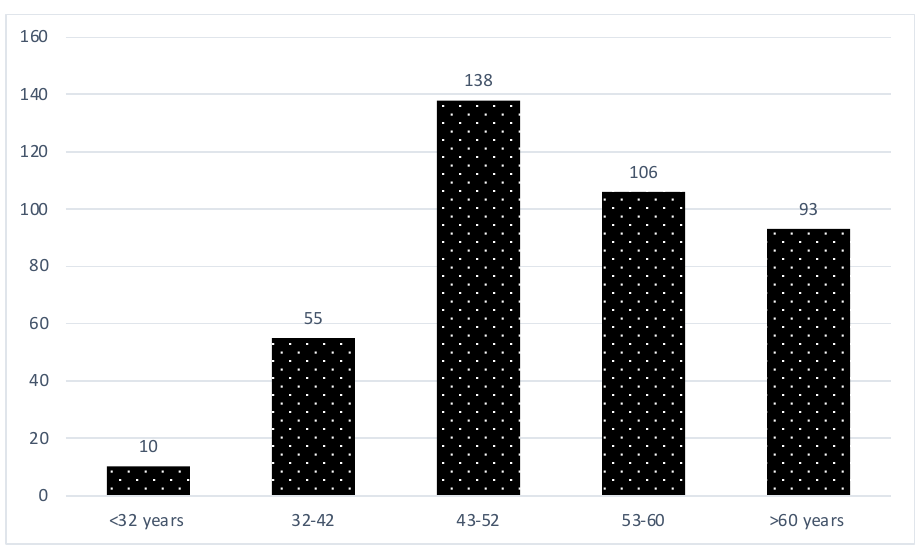
TABLE II - Details regarding the frequencies at which respondents performed diabetes self-care planning activities